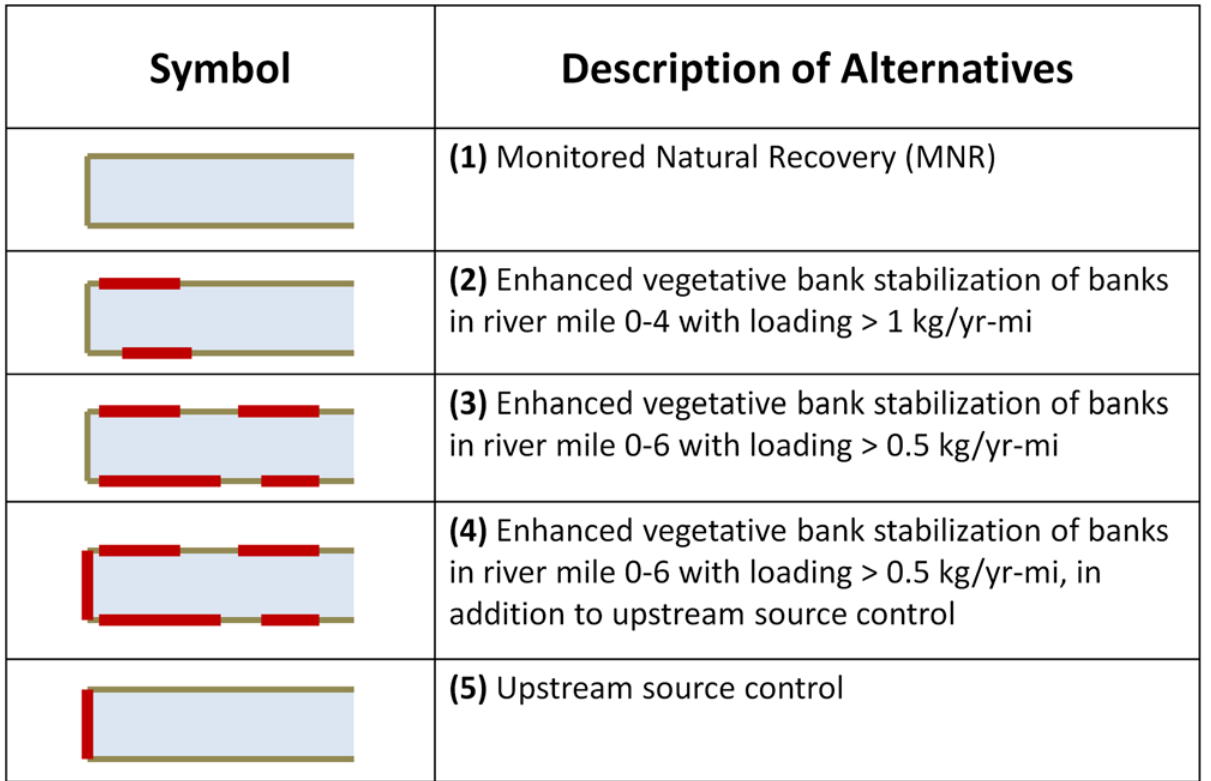
Figure 2. Remedial alternatives considered in the case study. The alternatives are different combinations of measures including vegetative bank stabilization, monitored natural recovery (MNR) in the reaches closest to the outfall, and outflow source control.